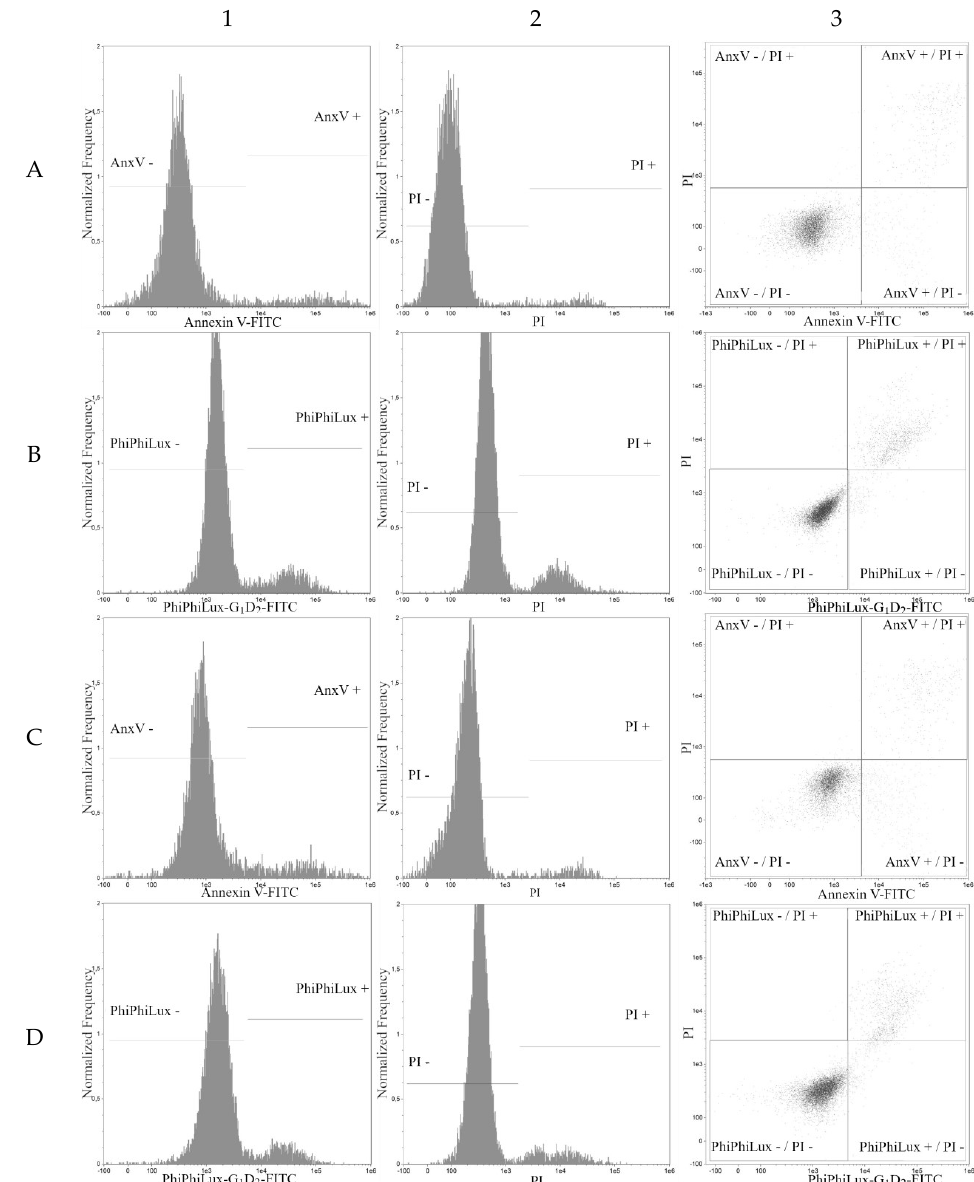
Figure 5. Apoptosis analysis of HL60 cell line. Graphs taken from FlowSight cytometer. All axes are shown in a logarithmic scale. (Columns: 1—Annexin V-FITC and PhiPhiLux-G1D2-FITC histogram;